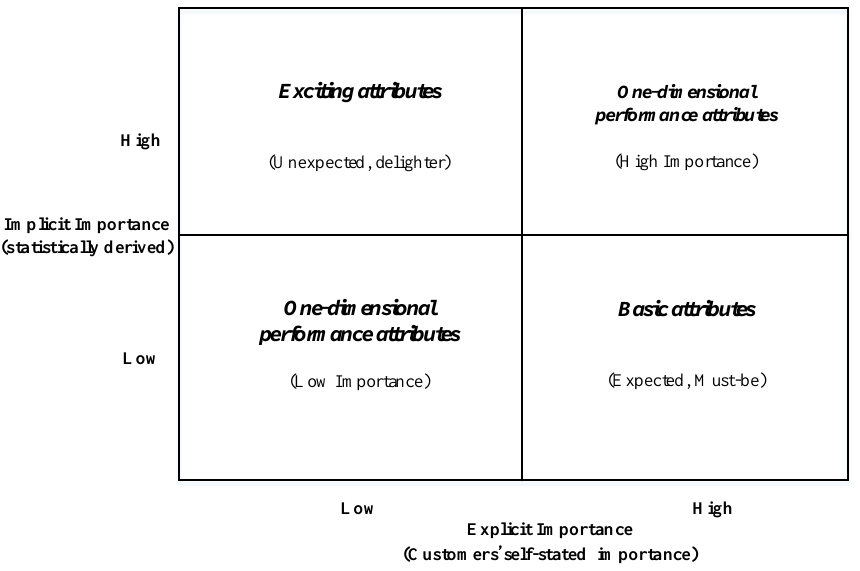
Figure 1. Importance grid for attributes (Vavra